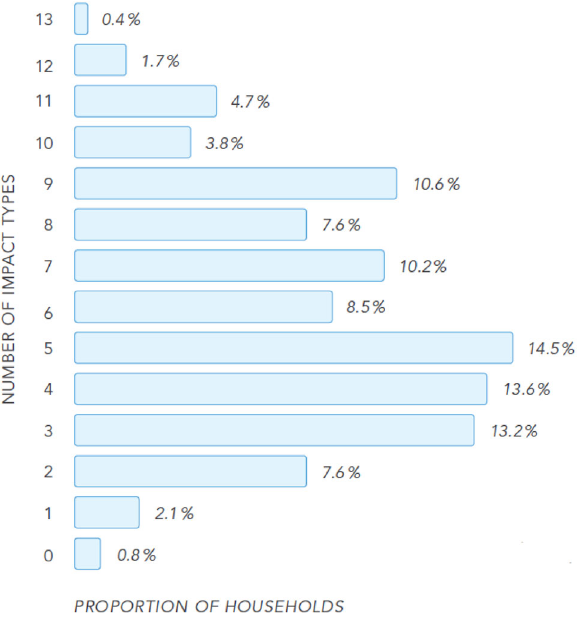
Fig. 6 Number of impact types experienced by households as a result of the 2 August 2014 Jure landslide in Sindhupalchok District, Nepal